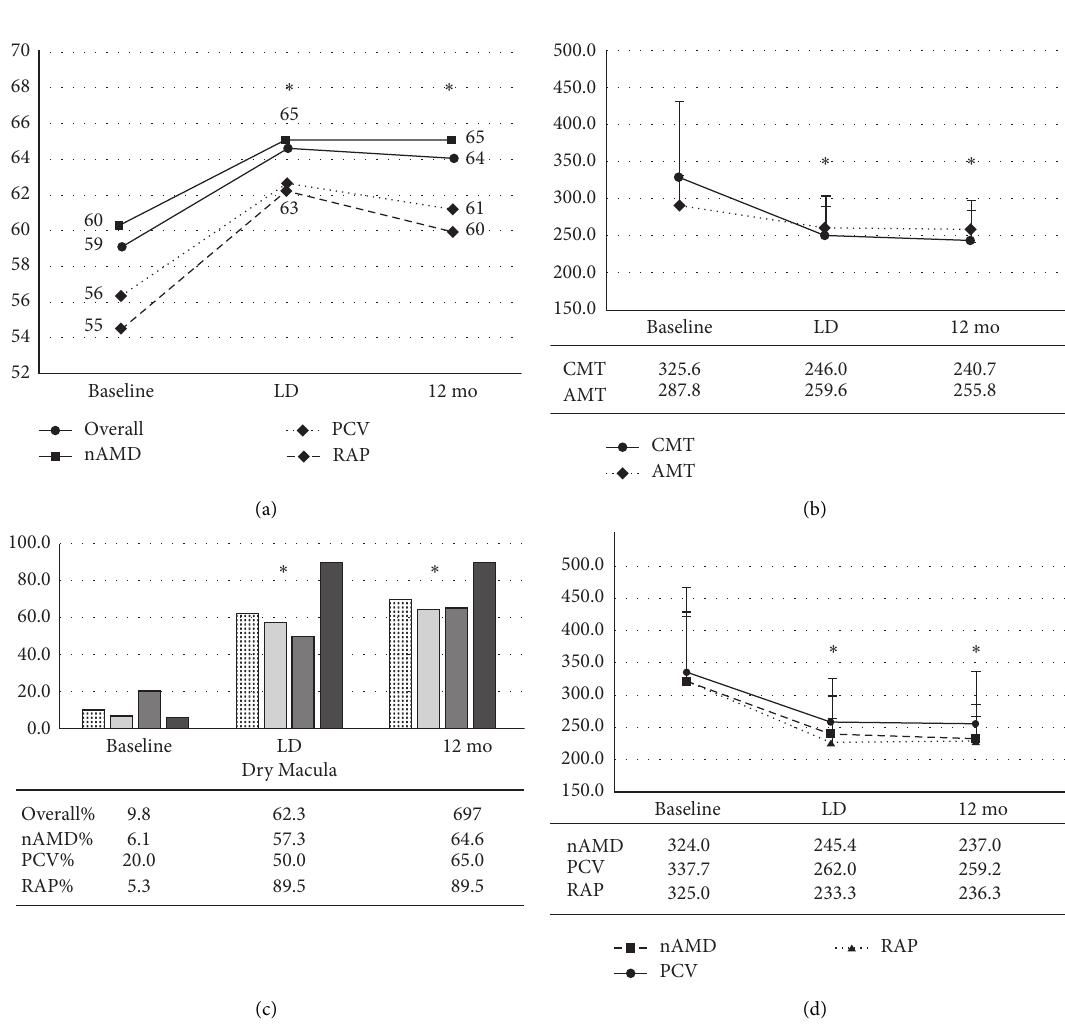
Figure 1: Changes in BCVA (ETDRS letters), CMT ( μ m), and AMT ( μ m) and percentage of dry macula during the study period. (a) Significant gain ( ∗ ) in mean BCVA was observed in overall ( p < 0 . 0001), nAMD ( p � 0 . 0004), and RAP ( p � 0 . 0017) after the loading dose (LD) and remained stable up to one year (12mo). BCVA changes in PCV were not significant. (b) Significant decrease ( ∗ ) in mean CMT ( p < 0 . 0001) and AMT ( p < 0 . 0001) was observed after the LD and was maintained until month 12. (d) Significant ( ∗ ) CMT improvement was also achieved for nAMD ( p < 0 . 0001), PCV ( p < 0 . 0001), and RAP ( p < 0 . 0001). (c) The percentage of eyes with dry macula was significant ( ∗ ) after the LD ( p < 0 . 0001) and also at 12 months ( p < 0 . 0001). Table 1: Best-corrected visual acuity (number of letters) in overall cohort, after loading dose (LD) and at final follow-up period